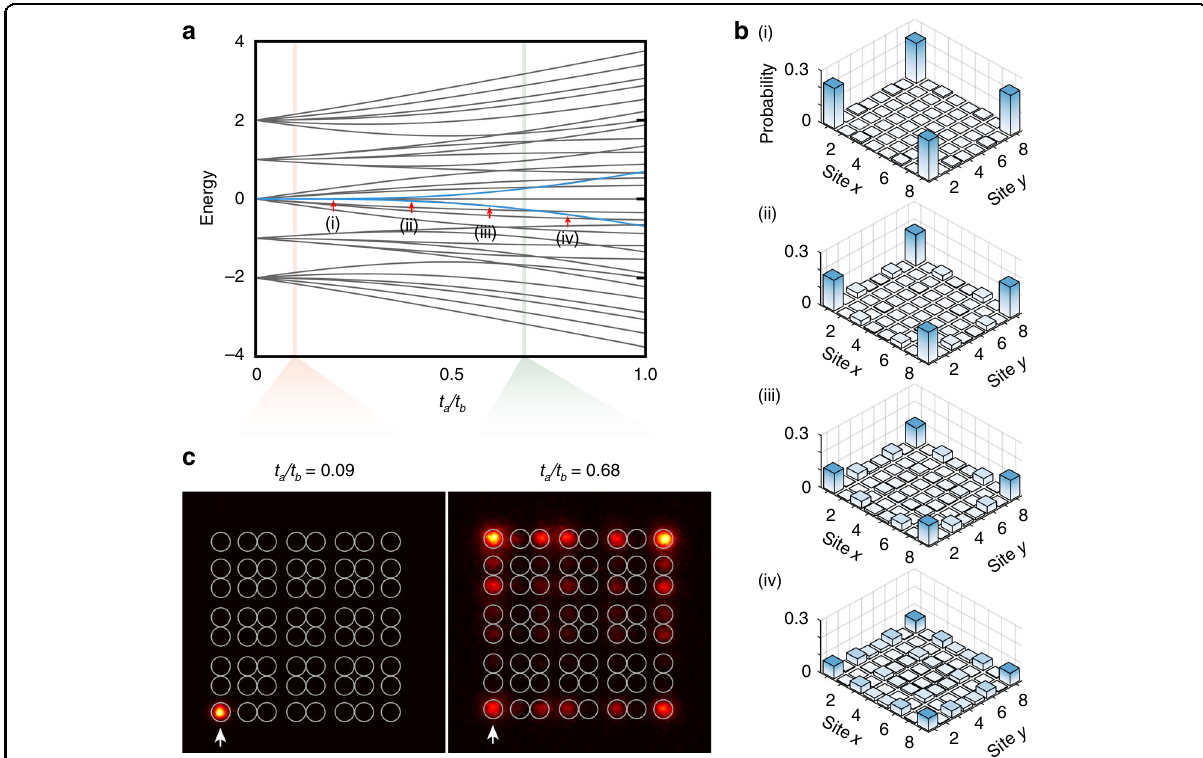
(cid:2) (cid:2) (cid:2) (cid:2) . a The spectrum of the lattices as the function of t i (cid:2) (cid:2) (cid:2) (cid:2) . The red and green regions indicate the range of = t i a b (cid:2) (cid:2) (cid:2) (cid:2) are adopted as 0.09 and 0.68 respectively, the evolution = t i a b